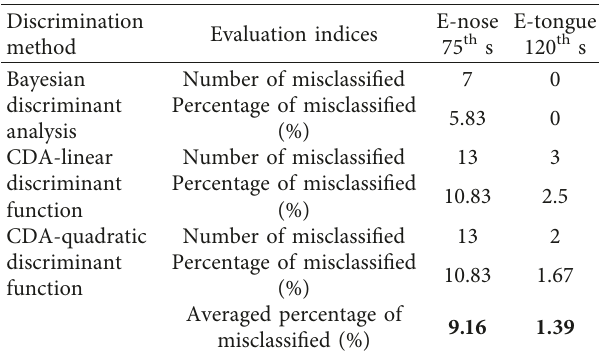
Table 4: Comparison results of discriminant analysis for responses of E-nose and E-tongue to minced mutton adulterated with